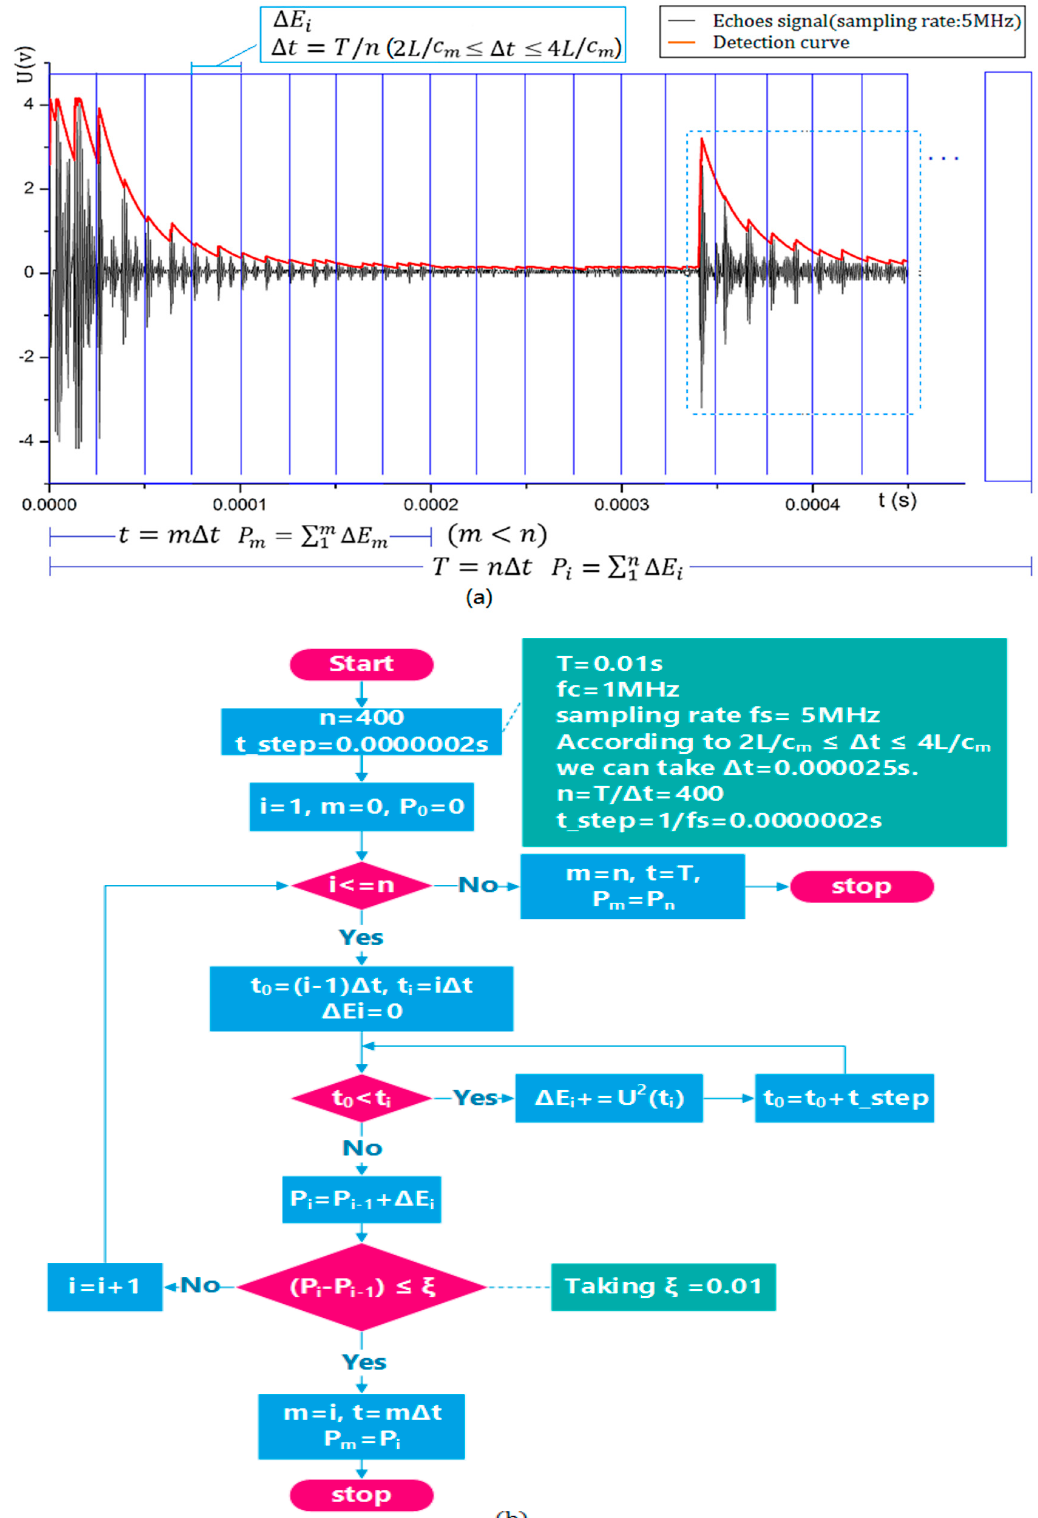
Figure 8. The algorithm that dynamically calculates the value of the time t and the valid echo energy: ( a ) is a schematic diagram, and ( b ) is a flow chart.